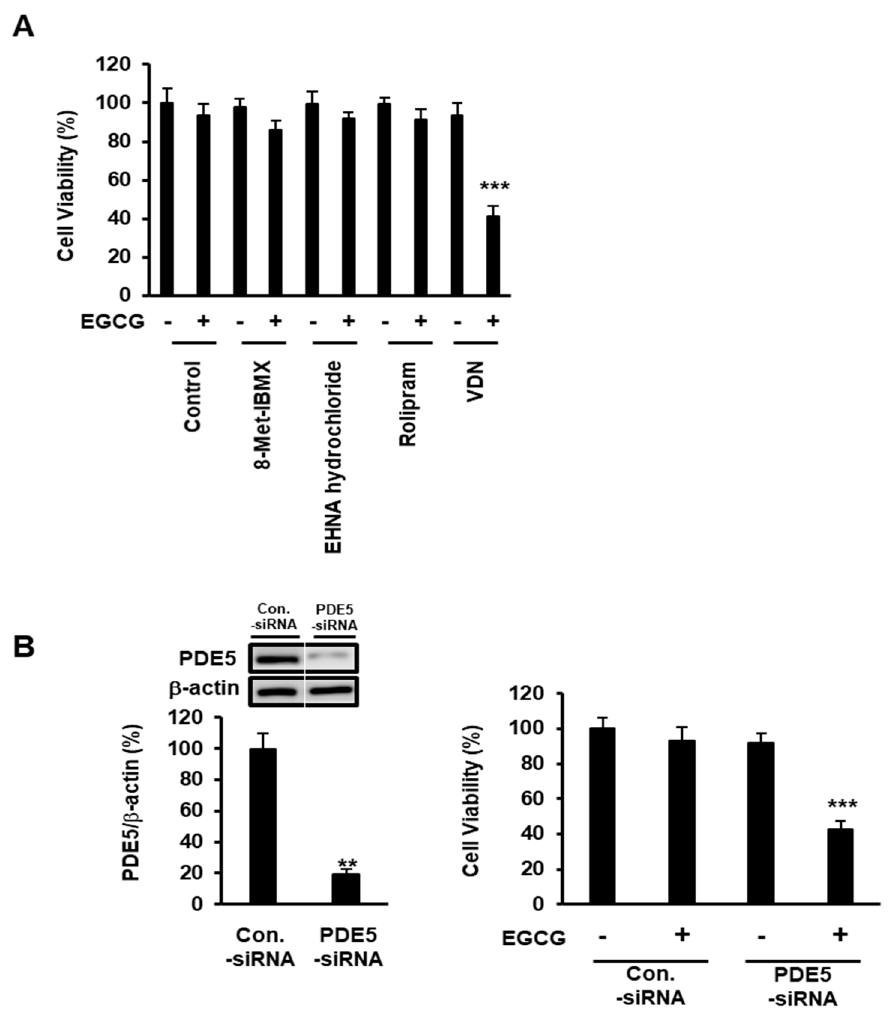
Figure 3. Expression of PDE5 attenuates EGCG-induced apoptotic cell death in colorectal adenocarcinoma. ( A ) Caco-2 cells were pretreated with PDE1 inhibitor 8-Met-IBMX (10 µ M), PDE2 inhibitor EHNA hydrochloride (5 μ M), PDE4 inhibitor rolipram (10 μ M), or PDE5 inhibitor VDN (5 μ M) for 96 h, then treated or not with EGCG (5 μ M) for 96 h. ( B ) Left: Immunoblot analyses of PDE5 in Caco-2 cells. Right: Sensitivity of EGCG (5 μ M for 96 h) of Caco-2 cells after knockdown of PDE5 expression. Data are presented as mean ± SEM ( n = 3); *** p < 0.001.